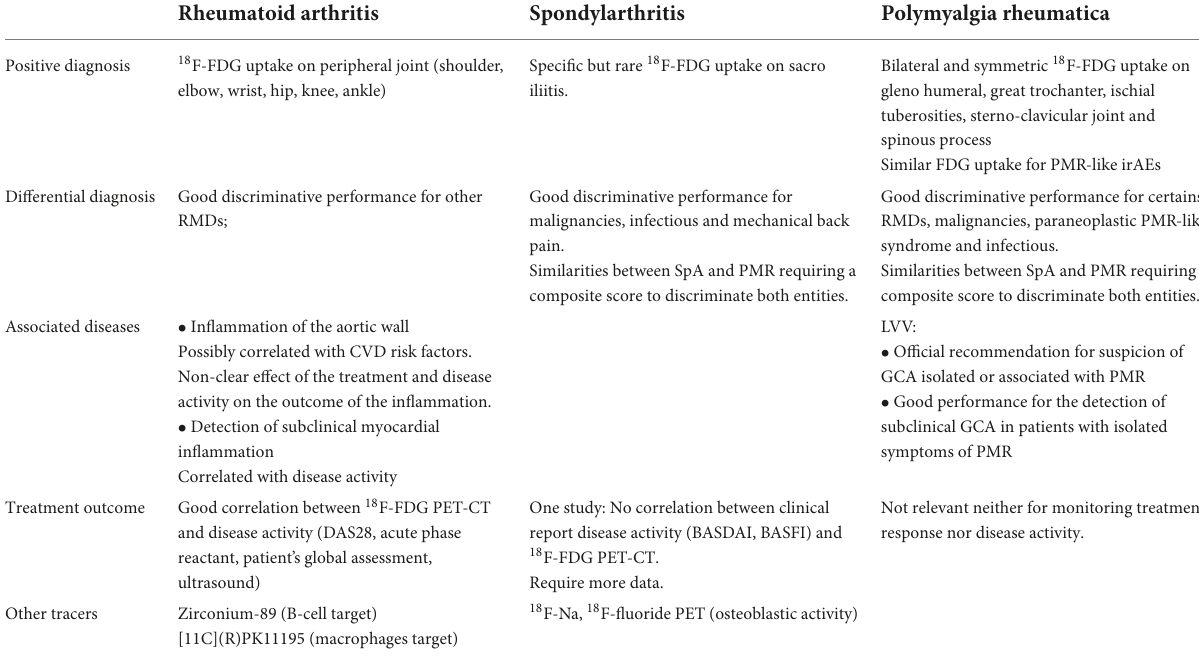
TABLE 1 Characteristics of 18 F-FDG PET-CT in RA, SpAs, and